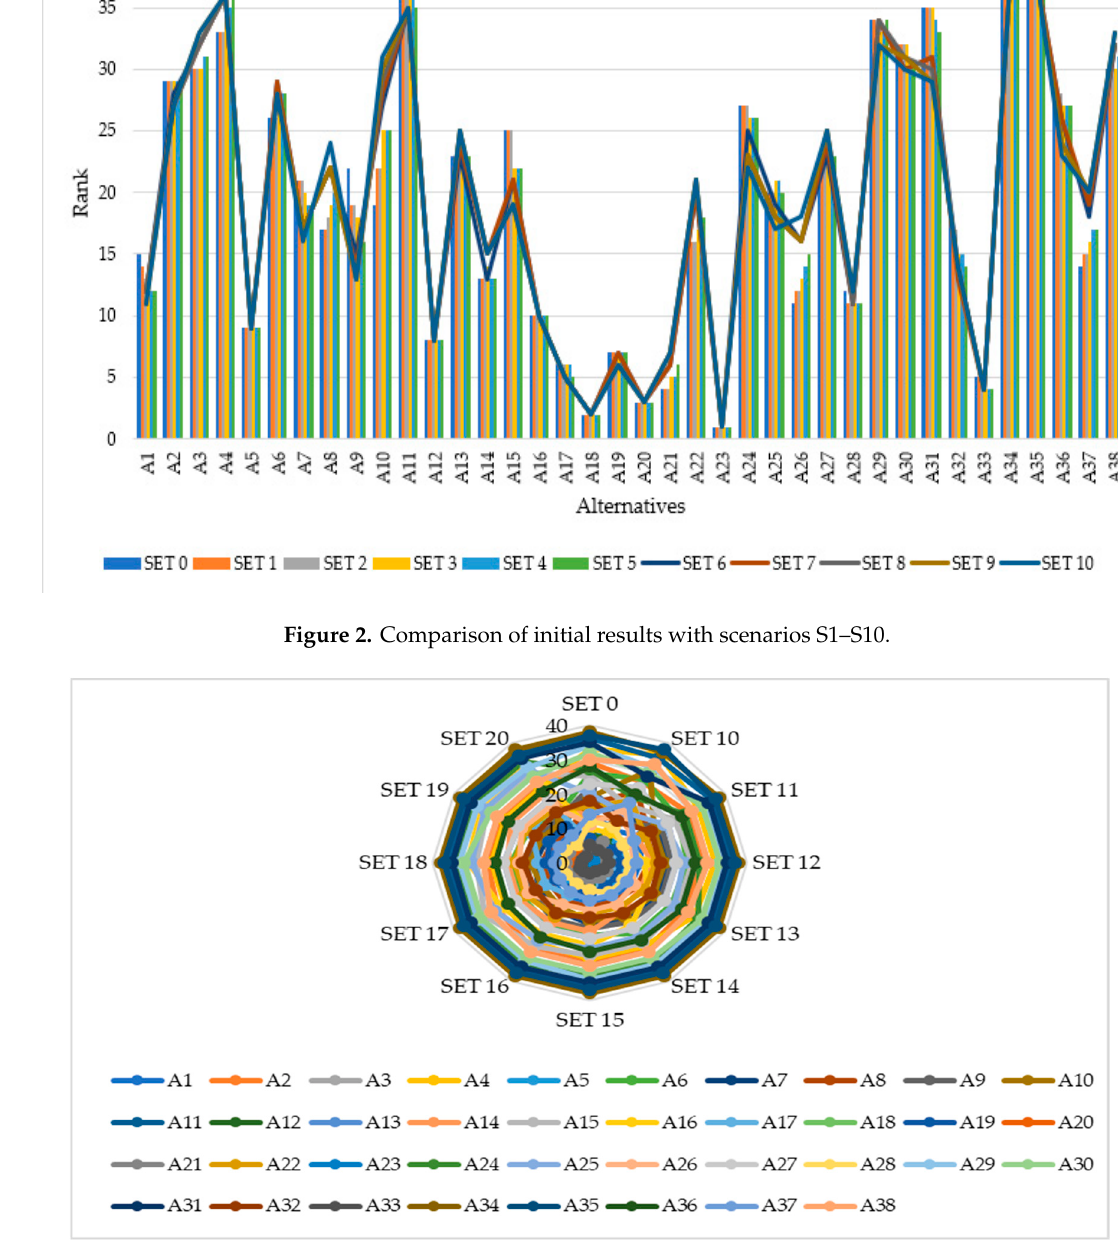
The change in the significance of the first criterion affects the ranks of road network sections, which is, in a way, understandable since there is a large number of alternatives. It is important to note that alternatives A23, A18, A20, A12, A5 and A16, which take the first, second, third, eighth, ninth and tenth places, respectively, do not change their positions in any scenario. With the